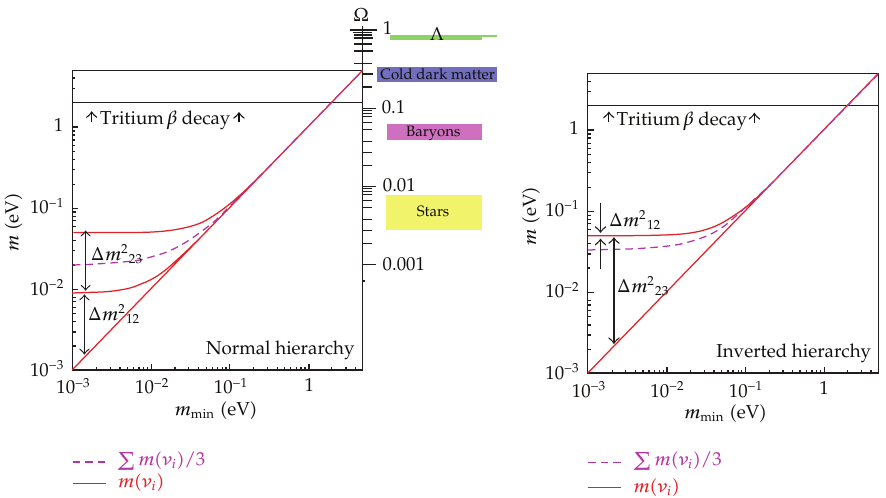
Figure 1: Neutrino mass eigenvalues 𝑚(𝜈 𝑖 ) (solid lines) and one-third of the cosmologically relevant sum of the three neutrino mass eigenvalues ∑𝑚(𝜈 𝑖 )/3 (dashed line) as a function of the smallest neutrino mass eigenvalue 𝑚 min for normal hierarchy 𝑚(𝜈 3 ) > 𝑚(𝜈 2 ) > ) = 𝑚 𝑚(𝜈 ) > 𝑚(𝜈 ) > 𝑚(𝜈 ) = 𝑚 𝛽 -decay experiments 𝑚(𝜈 1 min (left) and inverted hierarchy 2 1 3 min (right). The upper limit from the tritium at Mainz and Troitsk on 𝑚(𝜈 𝑒 ) (solid line), which holds in the degenerate neutrino mass region for each 𝑚(𝜈 𝑖 ) , and for ∑ 𝑚(𝜈 𝑖 )/3 (dashed line) is also marked. We plot here the third of the sum of the neutrino mass eigenstates because it coincides with the mass 𝑚(𝜈 𝑖 ) of the individualneutrinomassstatesinthecaseofquasi-degenerateneutrinomasses(for 𝑚(𝜈 𝑖 ) > 0.1 eV).Thetemperatureofthecosmicmicrowave background photons together with the different decoupling times of the relic photons and the relic neutrinos after the big bang yields a relic neutrino density of 336/cm 3 [6]. Using this number, the hot dark matter contribution Ω 𝜈 of neutrinos to the matter/energy density of the universe relates directly to the average neutrino mass ∑𝑚(𝜈 𝑖 )/3 . This hot dark matter component Ω 𝜈 is indicated by the right scale of the normal hierarchy plot and compared to all other known matter/energy contributions in the universe (middle). Thus, the laboratory neutrino mass limit from tritium 𝛽 -decay 𝑚(𝜈 𝑒 ) < 2 eV corresponds to a maximum allowed neutrino matter contribution in the universe of Ω 𝜈 < 0.12